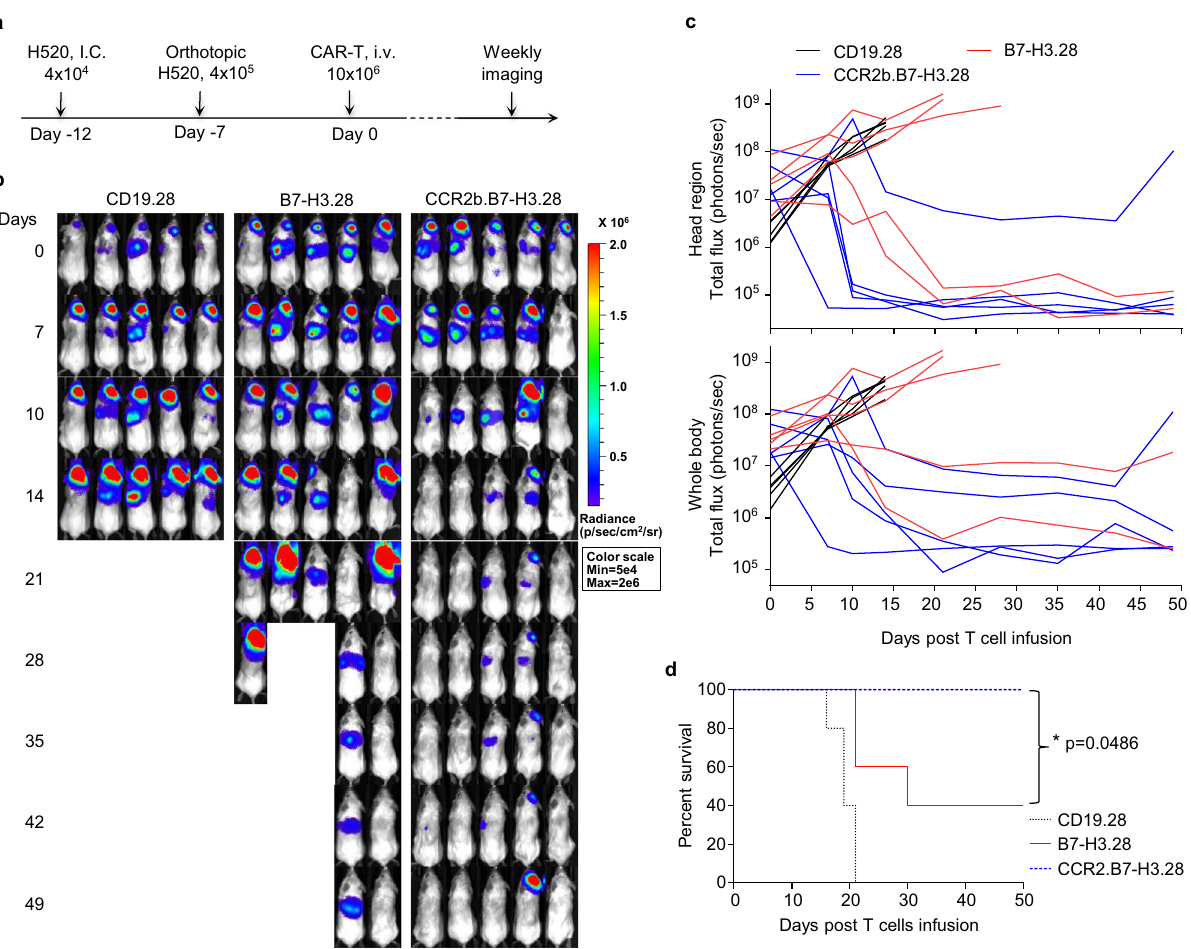
Fig. 6 CCR2b co-expressing B7-H3.CAR-T cells show superior antitumor activity in the H520 lung orthotopic and brain co-xenograft tumor model. a Schematic of the H520 lung orthotopic and brain co-xenograft tumor model in NSG mice. Brie fl y, the FFluc-H520 (4 × 10 4 ) cells were implanted into the right hemisphere of the brain of NSG mice by i.c. injection. Five days later, 4 × 10 5 FFluc-H520 cells were implanted into the left lung by intrathoracic injection. Seven days later, mice were treated with CD19.28, B7-H3.28, or CCR2b.B7-H3.28 CAR-T cells (10 × 10 6 cells/mouse) by i.v. injection. b Representative tumor BLI images. Days represent the days post T-cell infusion. c The BLI kinetics of the FFluc-H520 tumor growth in the model shown in ( b ), BLI signals from the brain (top) and whole body (bottom) are illustrated, respectively ( n = 5 mice/group). d Kaplan – Meier survival curves of mice in ( b ), n = 5 mice/group, * p = 0.0486 for B7-H3.28 vs. CCR2b.B7-H3.28, * p = 0.0181 for CD19.28 vs. B7-H3.28, ** p = 0.0026 for CD19.28 vs. CCR2b.B7- H3.28, χ 2 test. Source data for ( c , d ) are provided as a Source Data fi tumor speci fi c since we did not observe accumulation of CCR2b.B7-H3.CAR-T cells in the opposite hemisphere of the brain. Collectively, we demonstrated that CCR2b coexpression allows for signi fi cantly enhanced eradication of brain metastatic lesions of NSCLC. The concept of tailoring chemokine receptor to match chemokines expressed in brain metastases provides a unique approach to control these lethal tumor localizations by engi- neered T cell therapy.